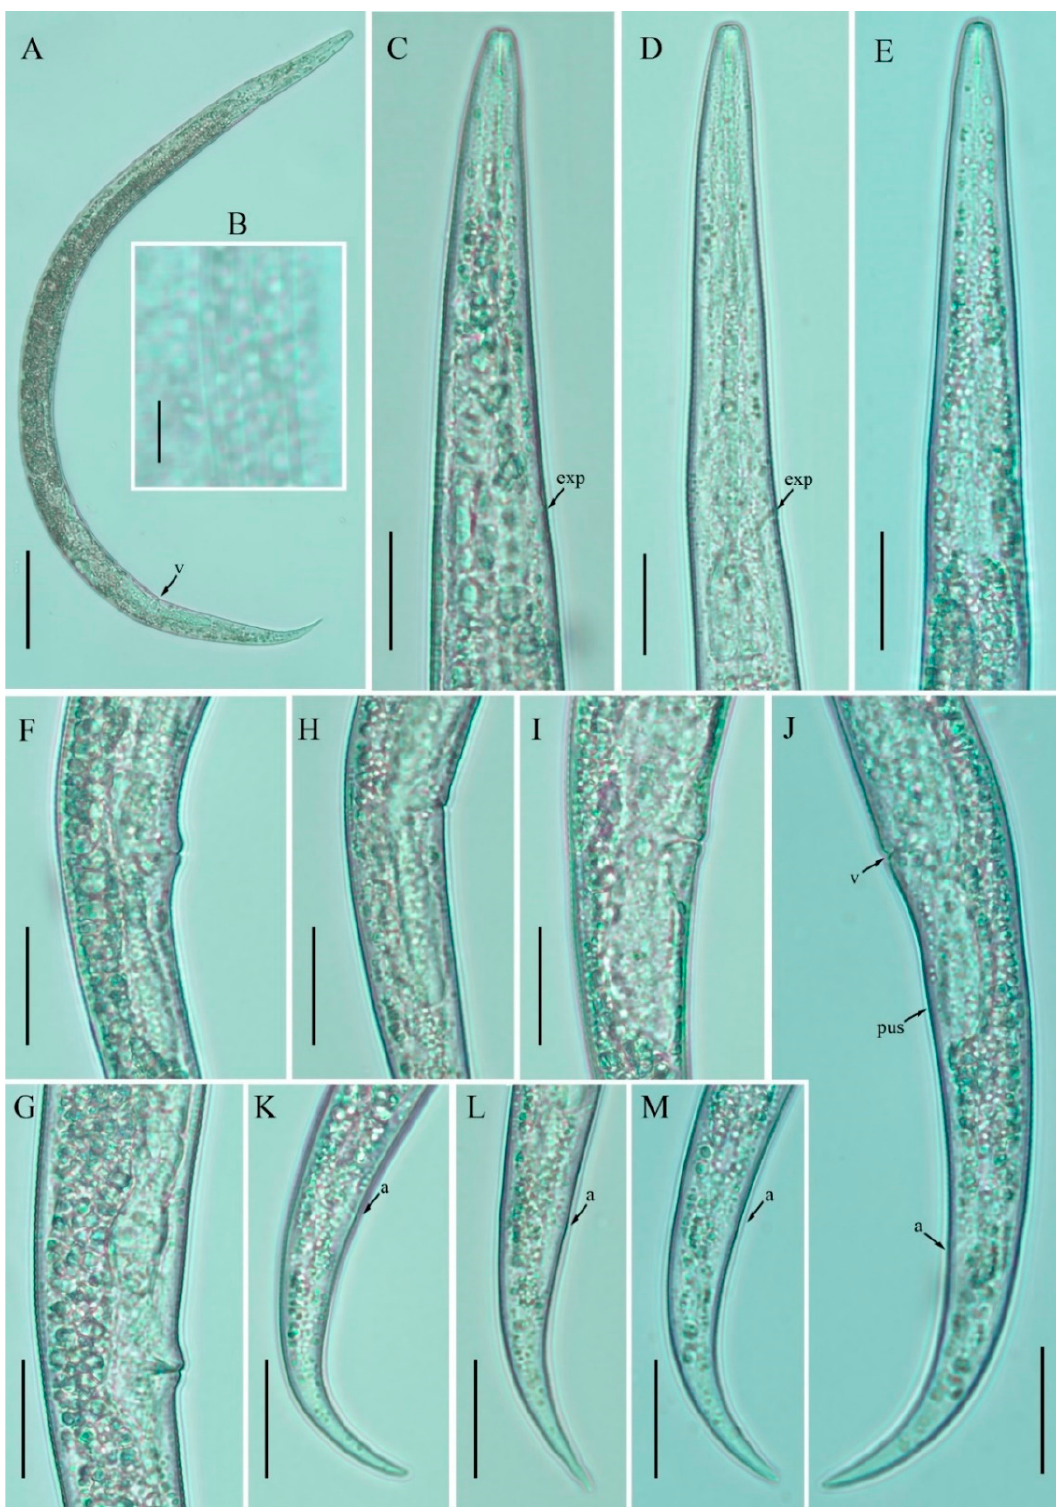
Figure 1. Photomicrographs of female Nothotylenchus medians . ( A ) Entire body; ( B ) lateral lines; ( C – E ) pharyngeal regions; ( F – I ) vulval regions; ( J ) posterior body to tail terminus; ( K – M ) tail regions. Scale bars: ( A ) 50 μ m; ( C – M ) 20 μ m; ( B ) 5 μ m. Arrowheads: (a) anus; (exp) excretory pore; (pus) post-vulval uterine sac; (v) vulva.